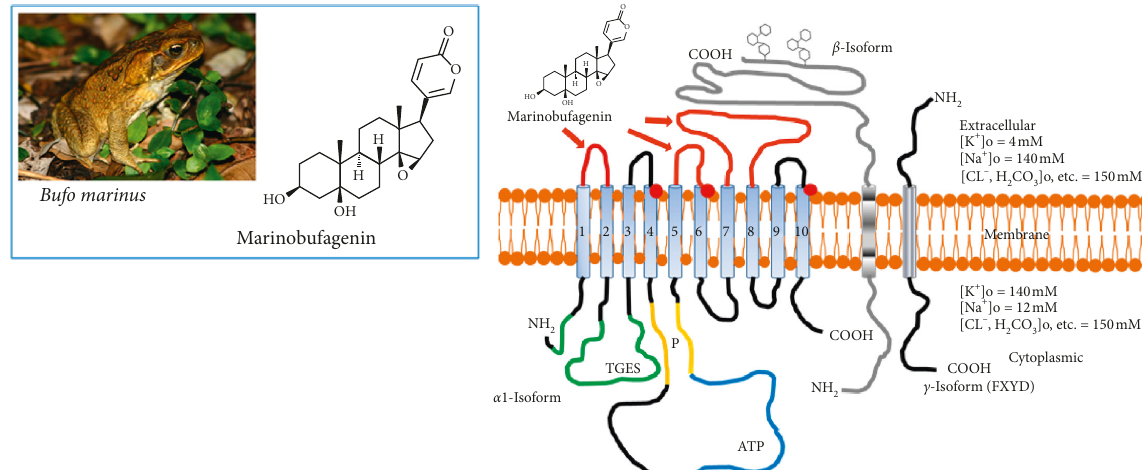
Figure 1: Chemical structures of bufadienolide, marinobufagenin and its pharmacological target,